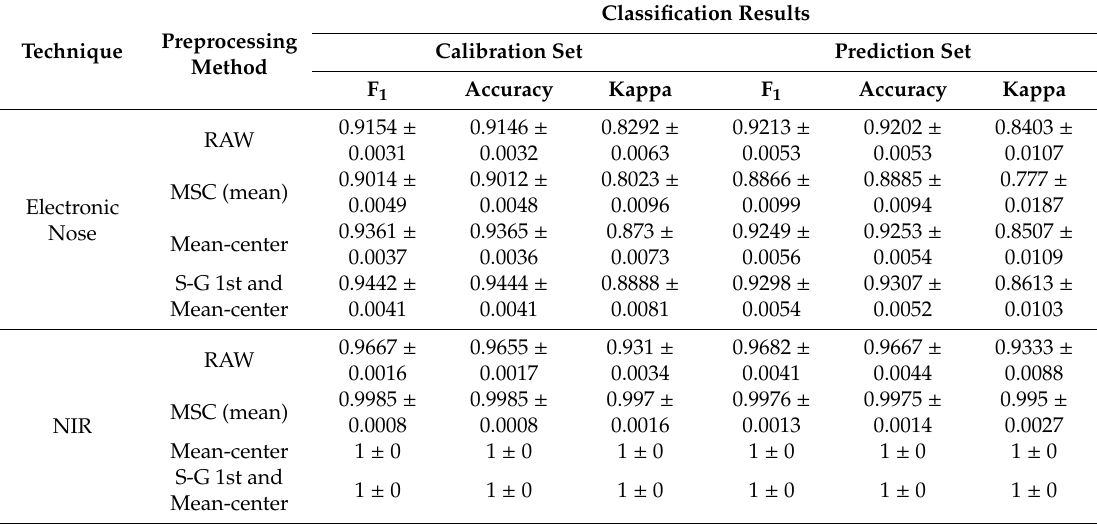
Table 4. The discrimination results of PLS–DA models based on di ff erent preprocessing methods.